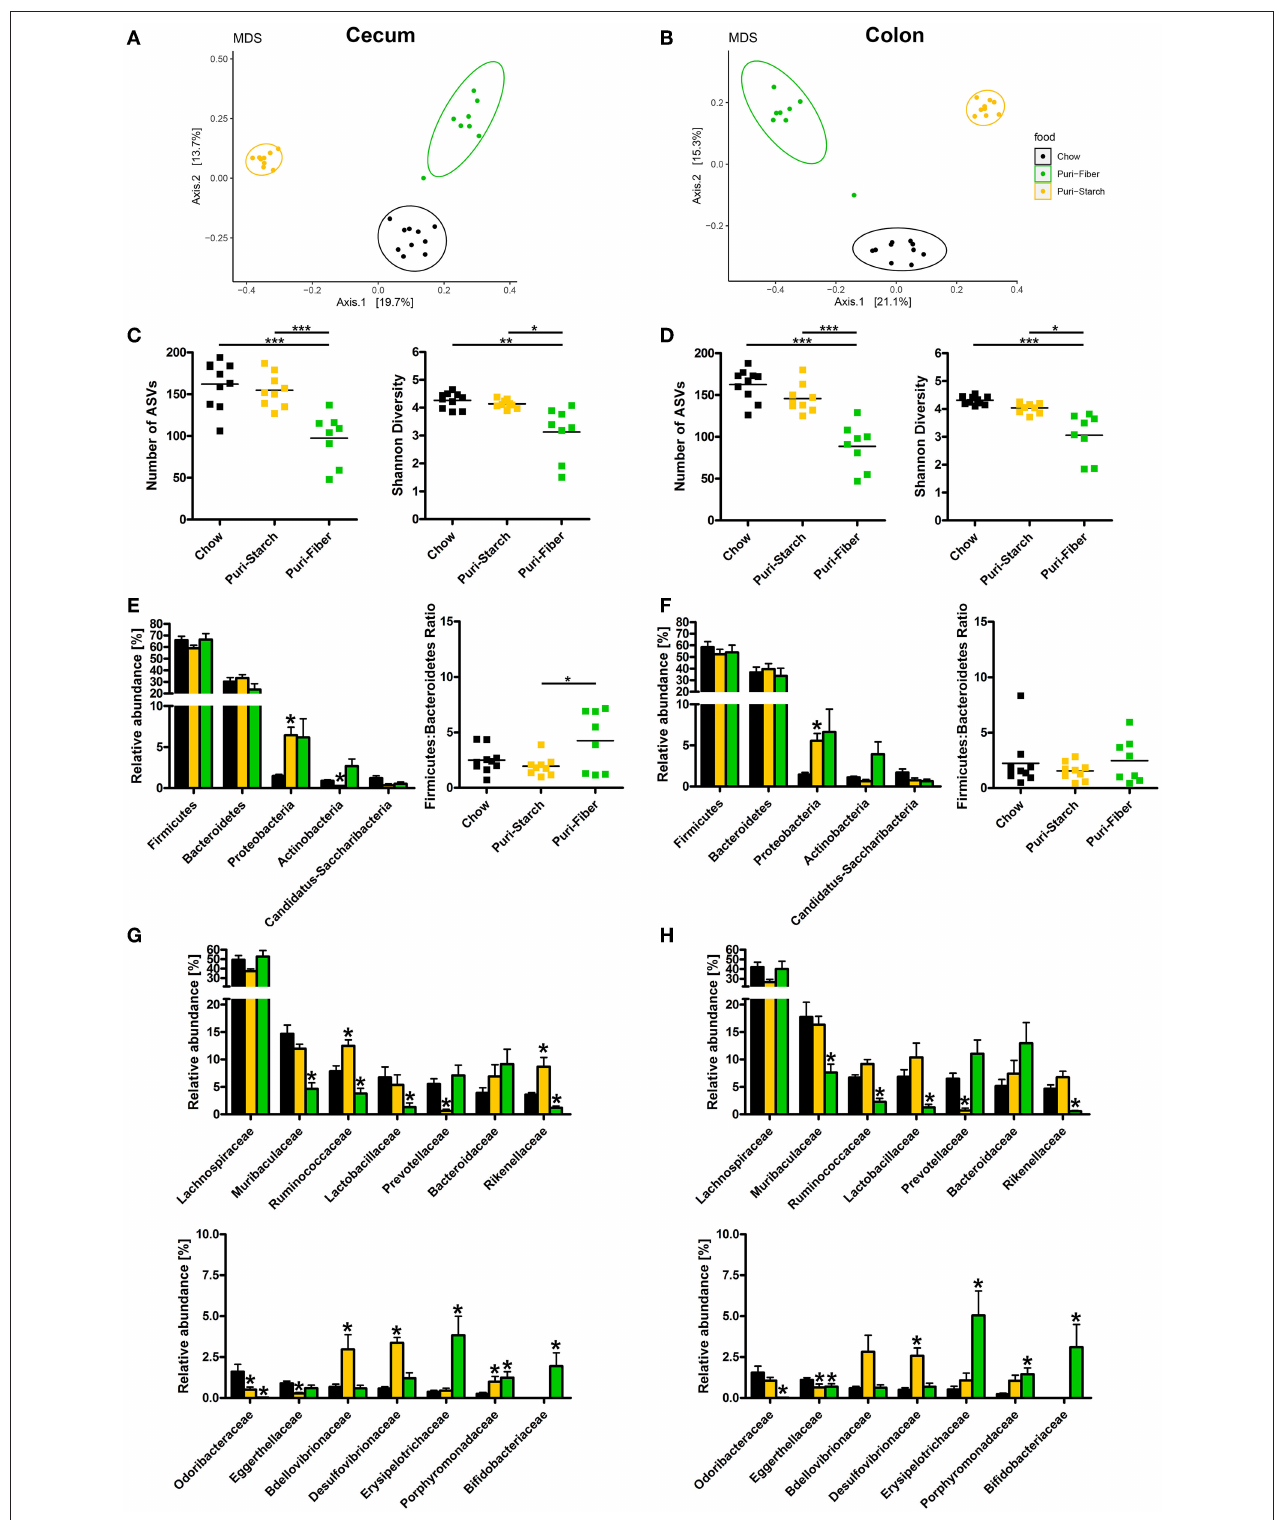
FIGURE 4 | Effects of diets on gut microbiota composition. (A,B) Microbial community composition of individual mice shown by multidimensional scaling analysis (principal coordinates based on Bray-Curtis dissimilarities). (C,D) Microbiota diversity; data are shown as individual data points with indicated means, * p < 0.05, ** p < 0.01, and *** p < 0.001 (one-way ANOVA and Tukey post-hoc tests). (E,F) Phyla relative abundances; data are shown as mean ± SEM, * p < 0.05 compared with